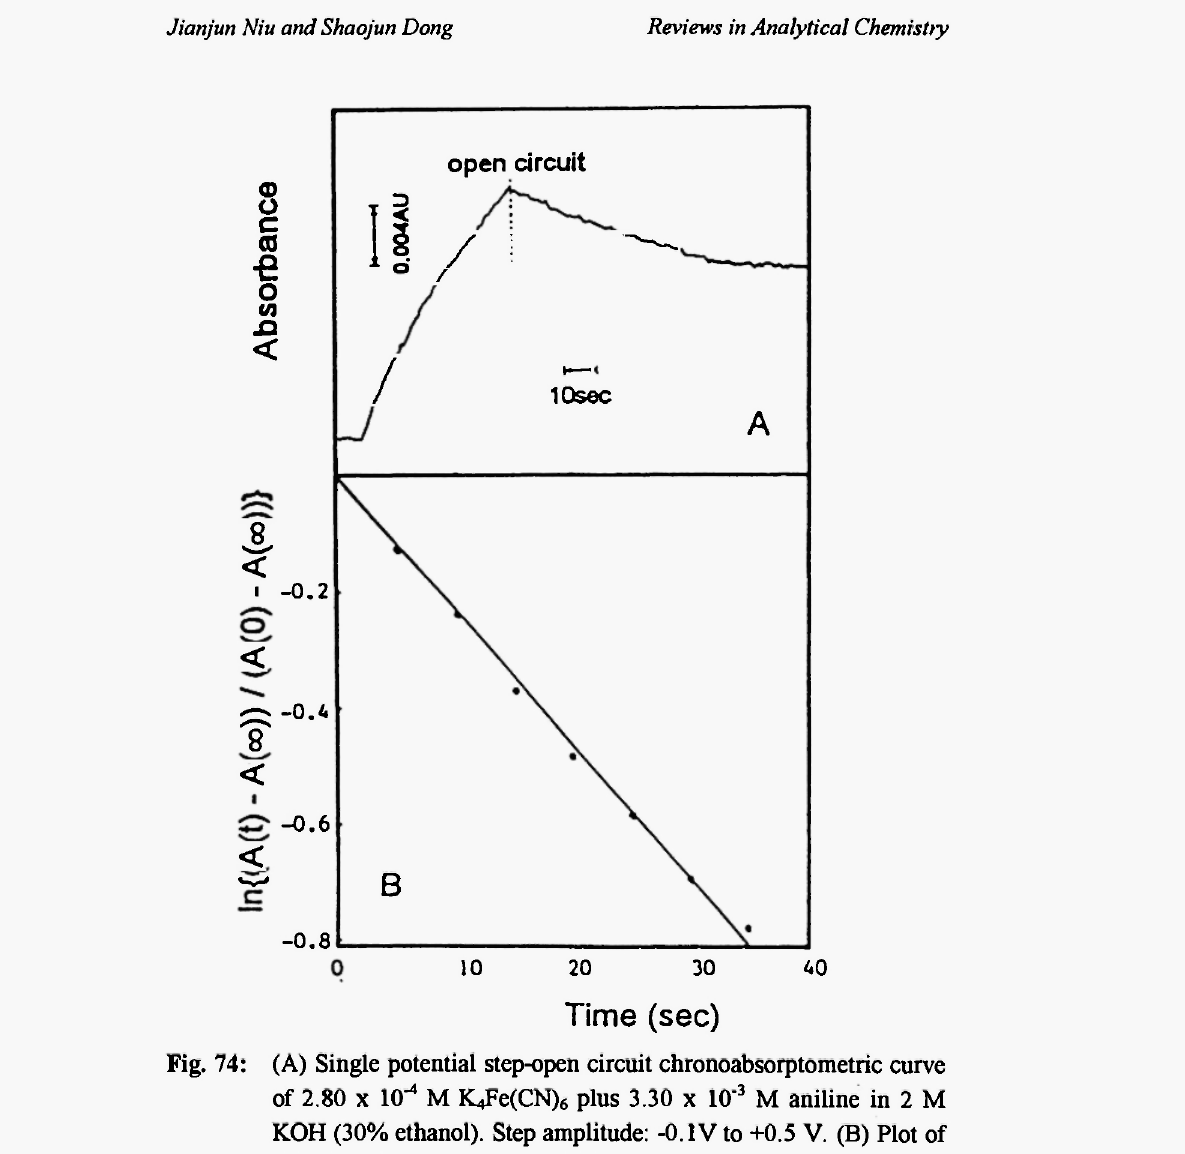
Fig. 74: (A) Single potential step-open circuit chronoabsorptometric curve of 2.80 χ ΙΟ" 4 Μ K4Fe(CN) plus 3.30 χ ΙΟ" 3 Μ aniline in 2 Μ 6 KOH (30% ethanol). Step amplitude: -0.1V to +0.5 V. (B) Plot of A"(t) against t . (From Ref.